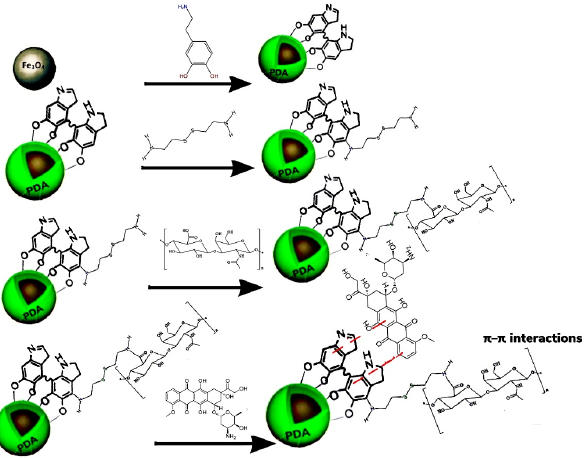
Figure 4. Schematic representation of a triple stimuli-responsive MNP drug carrier. Redrawn from [261].